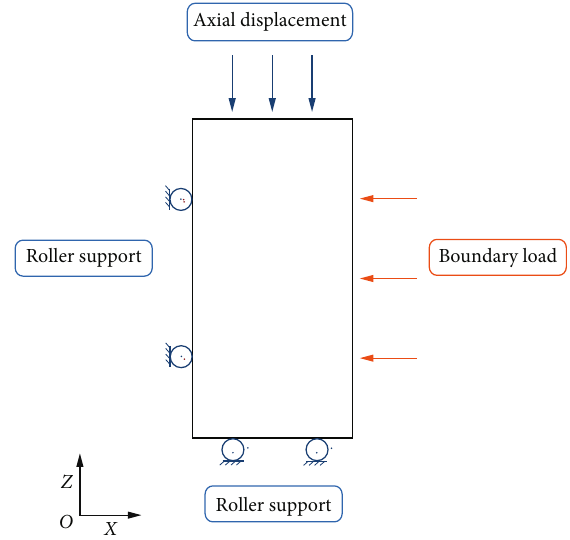
Figure 12: Numerical model of triaxial compression